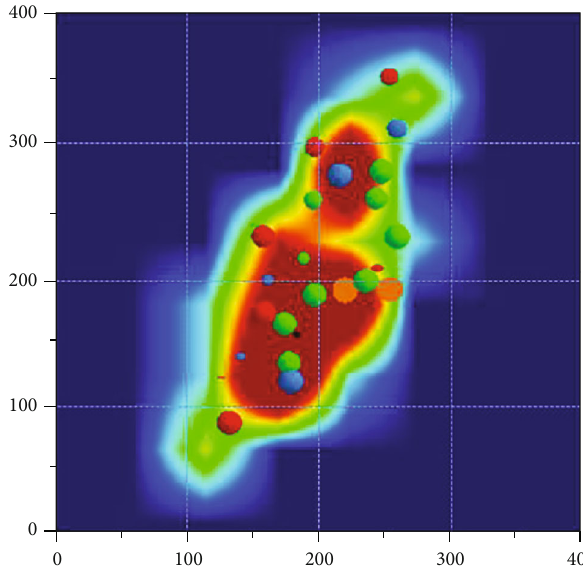
Figure 12: Results of microseismic monitoring of well